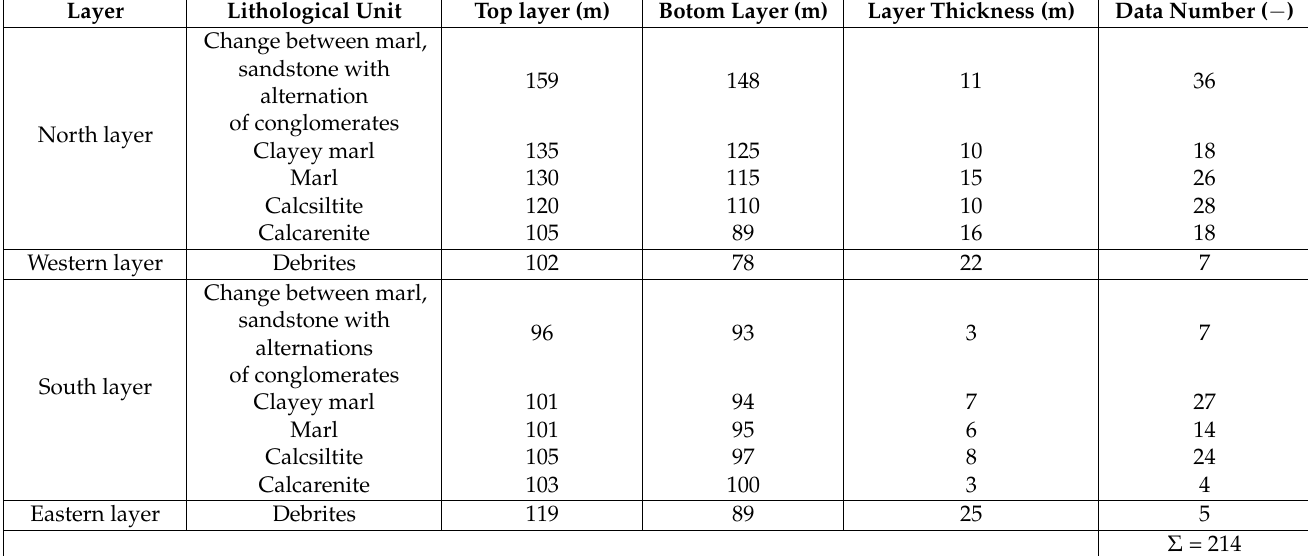
Table 1. Input data for the thickness calculations of the